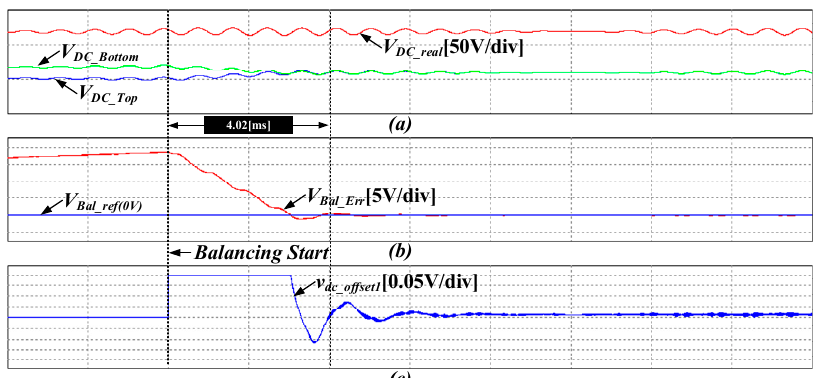
Figure 16. Simulation results of the DC-link neutral-point voltage balance used in 13-level cascaded NPC/H-bridge ( a ) DC-link voltage, ( b ) reference and error voltage between top capacitor and bottom capacitor, ( c ) offset voltage for DC-link voltage balancing.